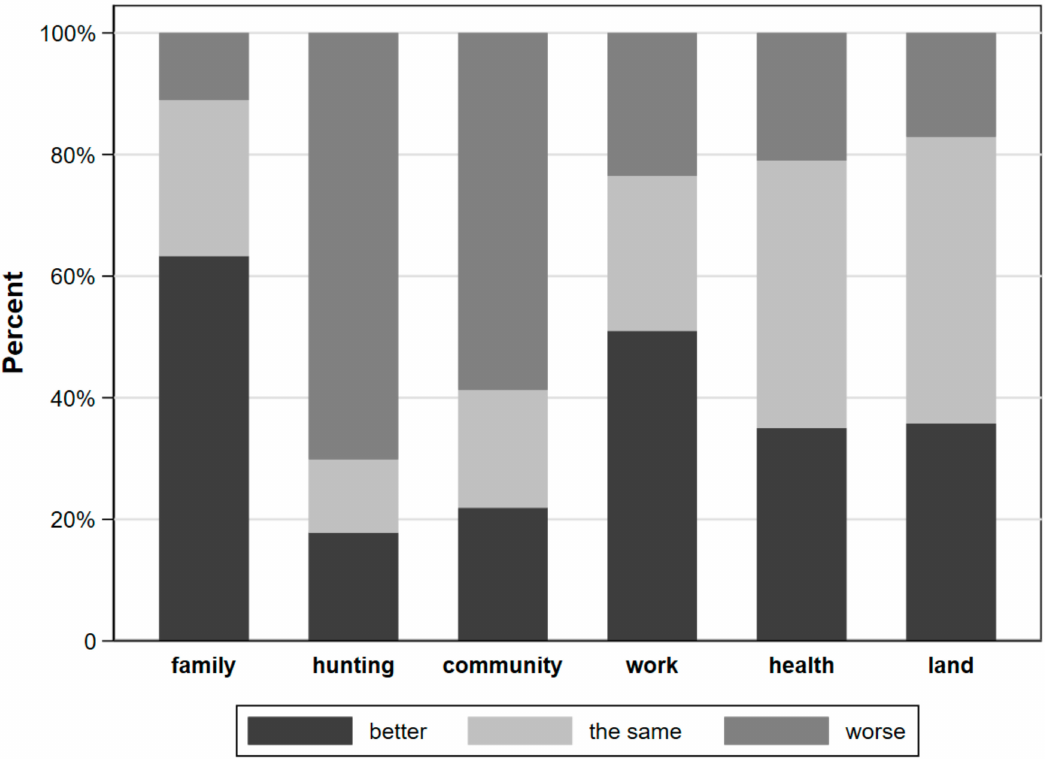
Figure 2. Perception of changes in each of the five capitals (is X is better/worse/the same since the IOH), were asked of long-term residents. Examples of questions relating to capitals include, Physical = access to hunting, fishing and forest products; Social = your community; Financial = possibilities for work; Human = your health; Personal = your